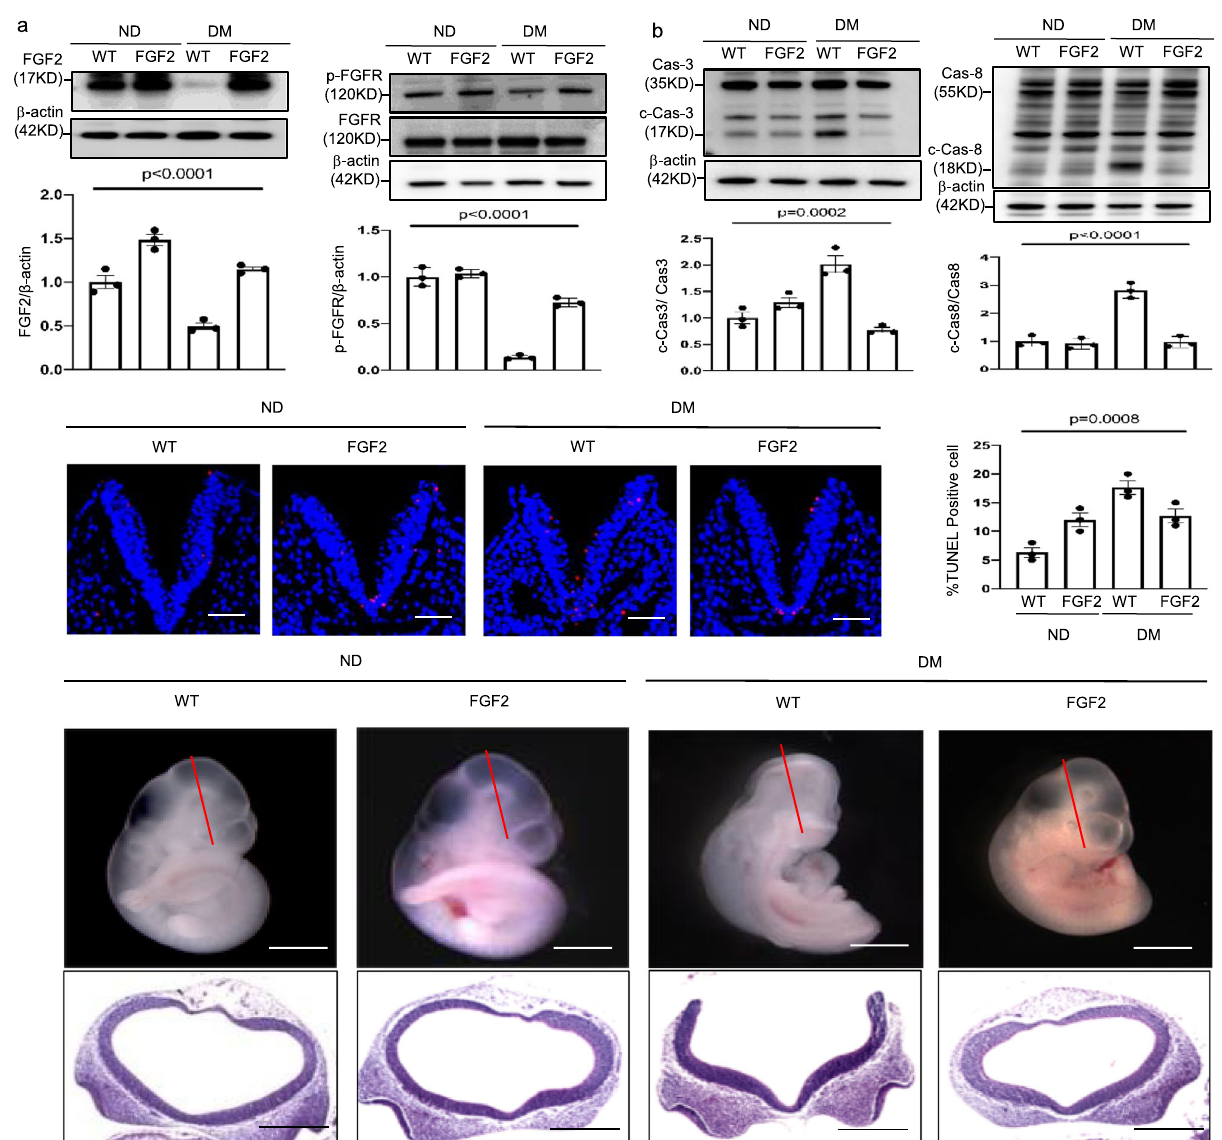
Fig. 3 FGF2 overexpression alleviates maternal diabetes-induced apoptosis and NTD formation. a Protein abundance of FGF2 and (p)-FGFR in E8.5 embryos. b Protein abundance of cleaved caspase 3 and caspase 8 in E8.5 embryos. c Representative TUNEL assay imaging showing apoptotic cells (red dots) in sections at the midbrain-hindbrain boundary of the E8.5 neuroepithelium. Cell nuclei were stained with DAPI (blue), bars = 30 μ m. The bar graph shows quanti fi cation of TUNEL-positive cells. d Imaging of WT and FGF2 Tg overexpressing embryos. Experiments were performed using three embryos from three different dam per group ( n = 3). Bars = 200 μ m and 100 μ m, for the top panel and the low panel, respectively. * indicates signi fi cant difference compared to other groups ( P < 0.05). ND nondiabetic, DM diabetes mellitus, WT wild type, FGF2 FGF2 transgenic